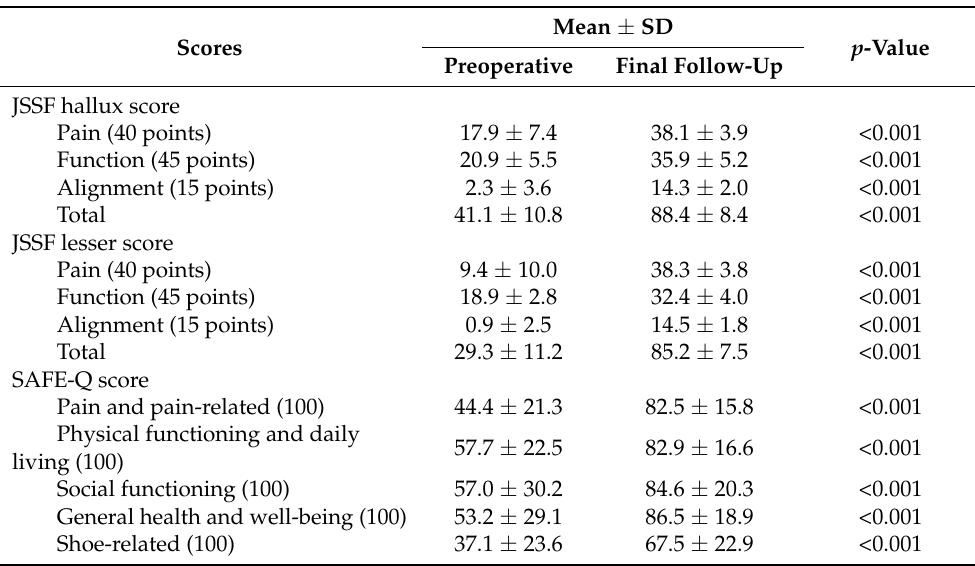
Table 2. Changes in the Japanese Society for Surgery of the Foot (JSSF) and postoperative self- administered foot evaluation questionnaire (SAFE-Q)